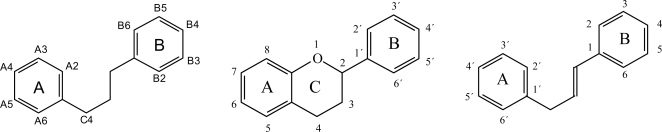
Simplified C6-C3-C6 structure (left) of flavonoids (centre) and chalcones (right).